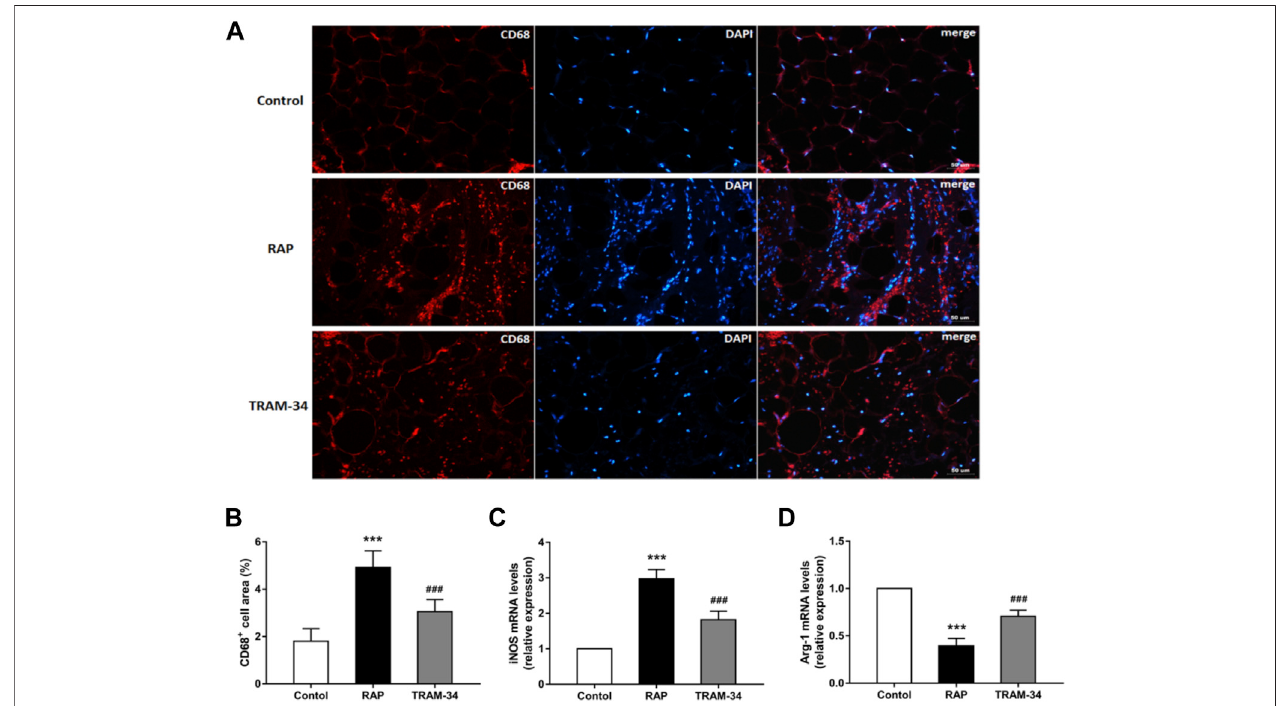
FIGURE5| LevelsofCD68 + ,iNOS,andarg1intheARGPinthethreegroups.Representativeimagesandquantitative analysisofimmuno fl uorescencestainingfor CD68 + (red)intheARGP (A,B) (n=6,40X).QuantitativeanalysisofRT-PCRofiNOSandarg1inARGP (C,D) .RAPincreasedthesecretionofin fl ammationcytokinesand promoted macrophage polarization from M2 to M1 compared to that in the control group. However, TRAM-34 can attenuate this effect. *** p < 0.01vs the control group and TRAM-34 group; ### p < 0.01vs the control group.